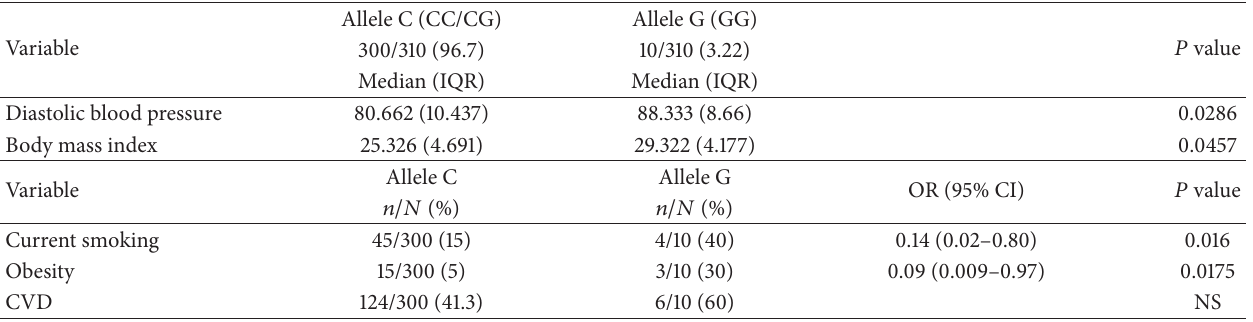
Table 4: Characteristics associated with allele C of the GDF15 rs1058587 SNP in RA patients.